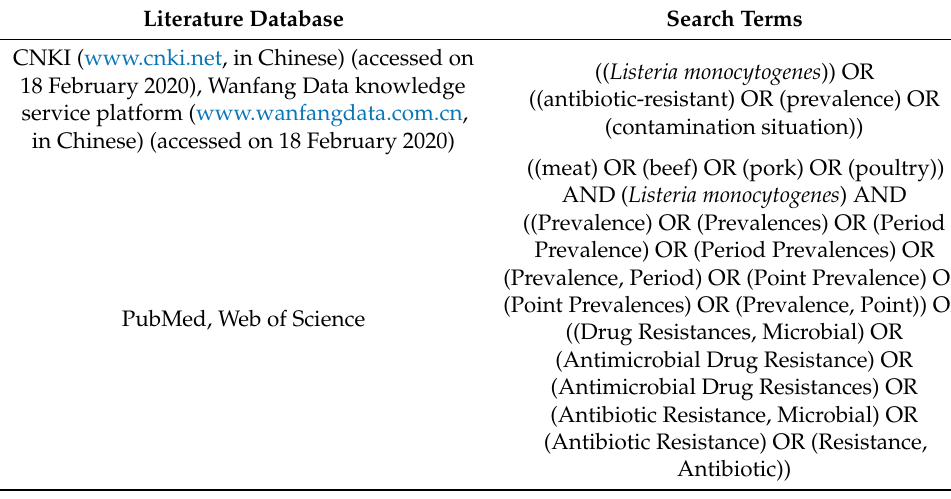
Table 1. Search terms used in each literature